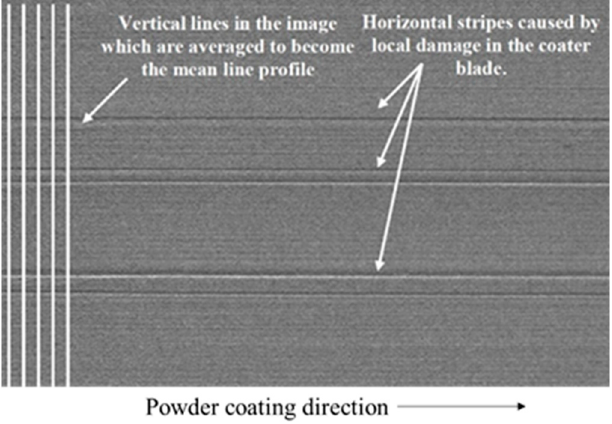
Figure 6. Image of deposited powder bed with worn coater blade [21].